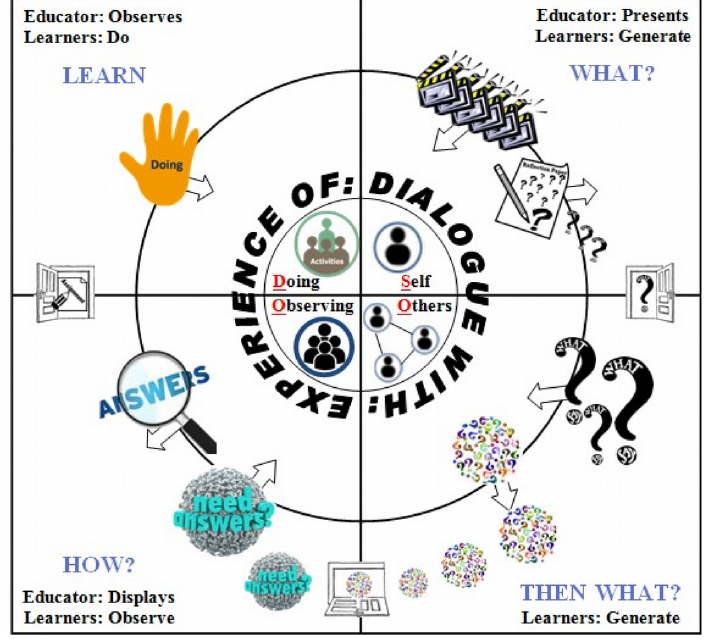
Figure 4. Stages of the VFC